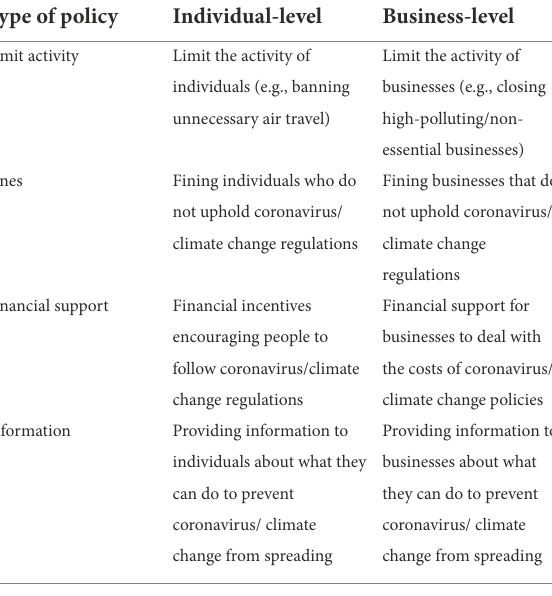
TABLE 2 Matched policy measures to address coronavirus and climate change.